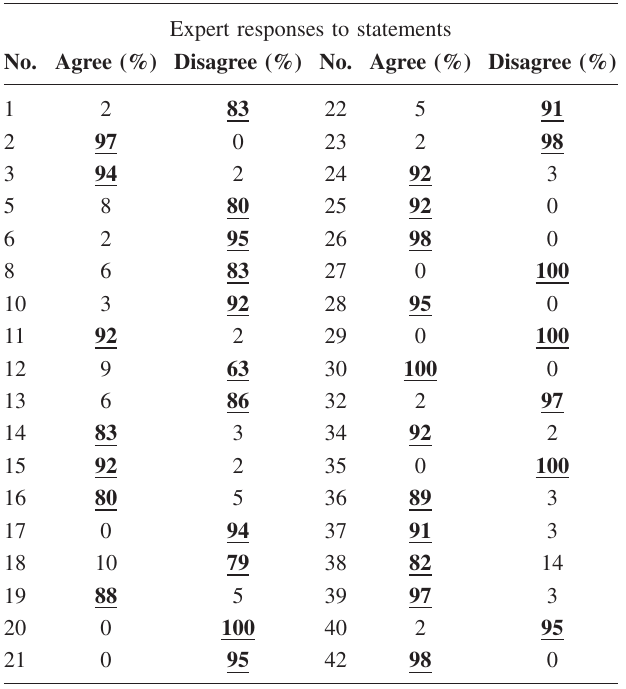
TABLE III. The responses from 66 U.S. university and college physics faculty on the